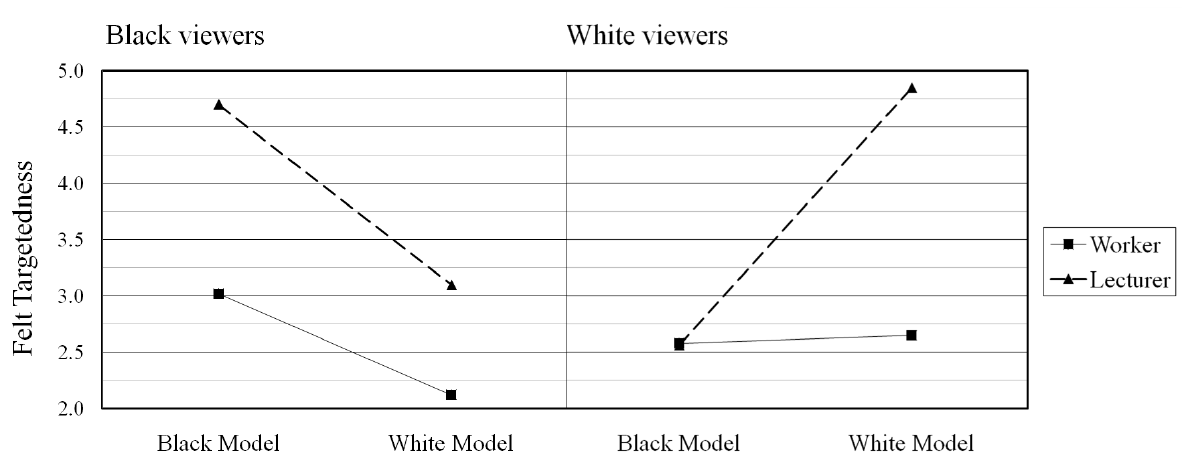
Figure 3: H 2 – Three-way interaction viewers’ racial group × Model’s racial group × Model’s profession on felt targetedness Table 2: Hypothesis H 3 – Linear